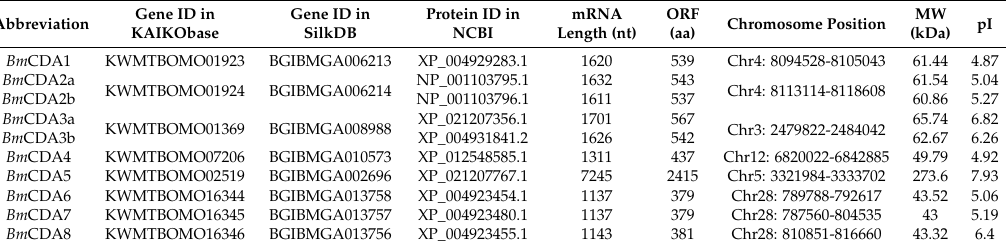
Figure 1. ( A ) Schematic diagram of the exon – intron organizations of eight Bombyx mori chitin